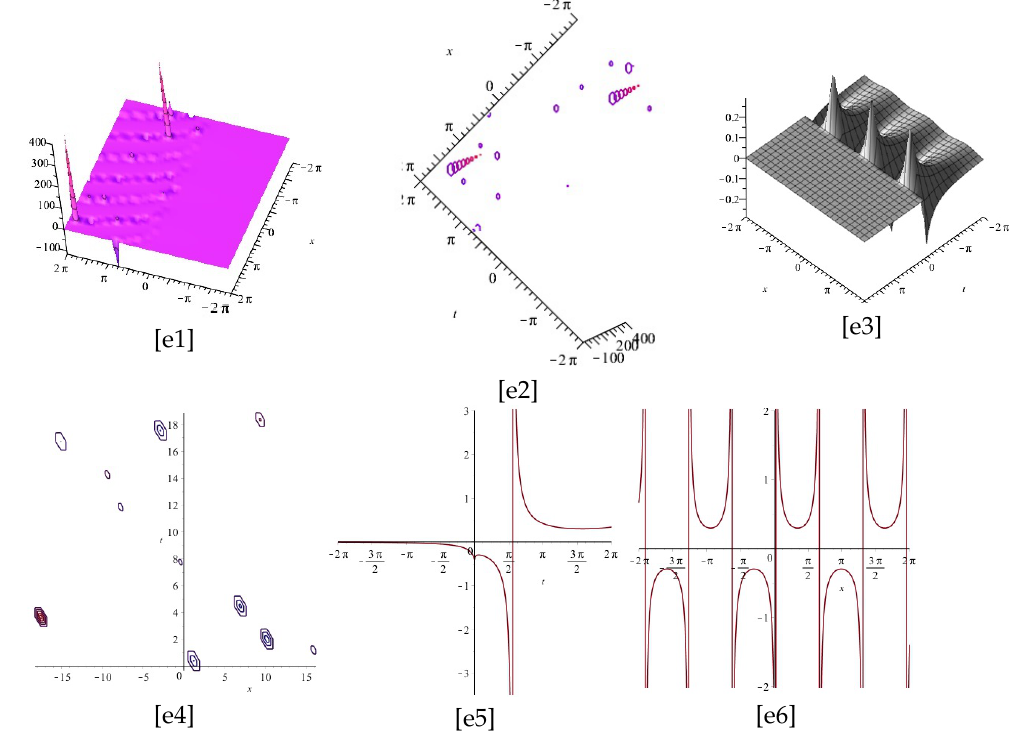
Figure 5. The plots of Equation (30), for λη > 0 and α = 0.5. Now, [e1] and [e3] are imaginary and real parts of Equation (30), and [e2], [e4], [e5], and [e6] display the z -axis orientation, the contour plot, the 2d for x = 2, and the 2d for t = 2, of the imaginary part of [e1], respectively.